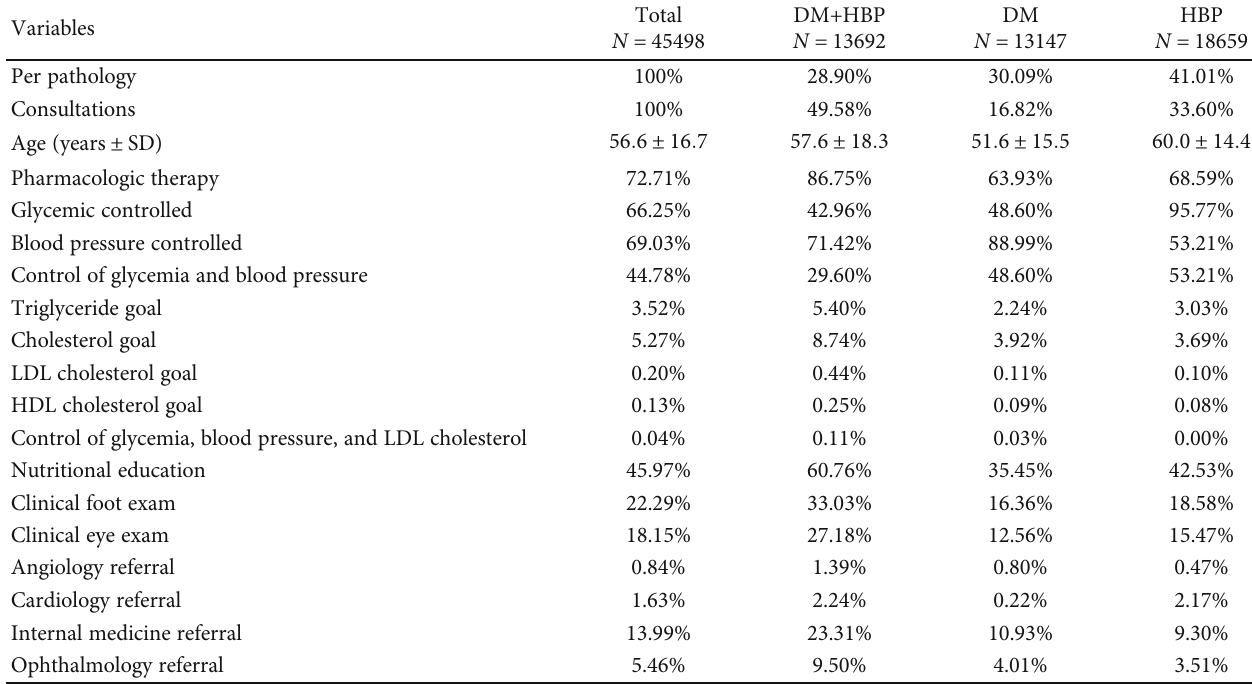
Table 2: Percentage of patients reaching control and management goals.